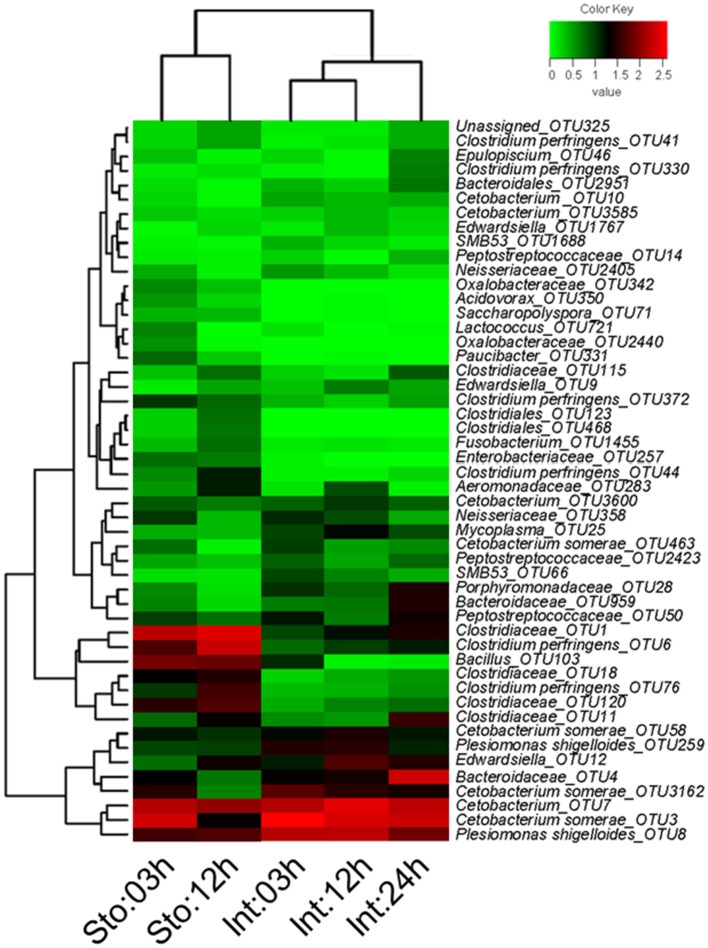
Heatmap of showing the relative abundance reveals obvious microbial dynamics and compositional differences between stomach and intestine after feeding. Columns are arranged by similarity using hierarchical clustering. The relative abundance data was log 10 transformation. Bray-Curtis clustering based on top 50 OTUs in the stomach and intestine.